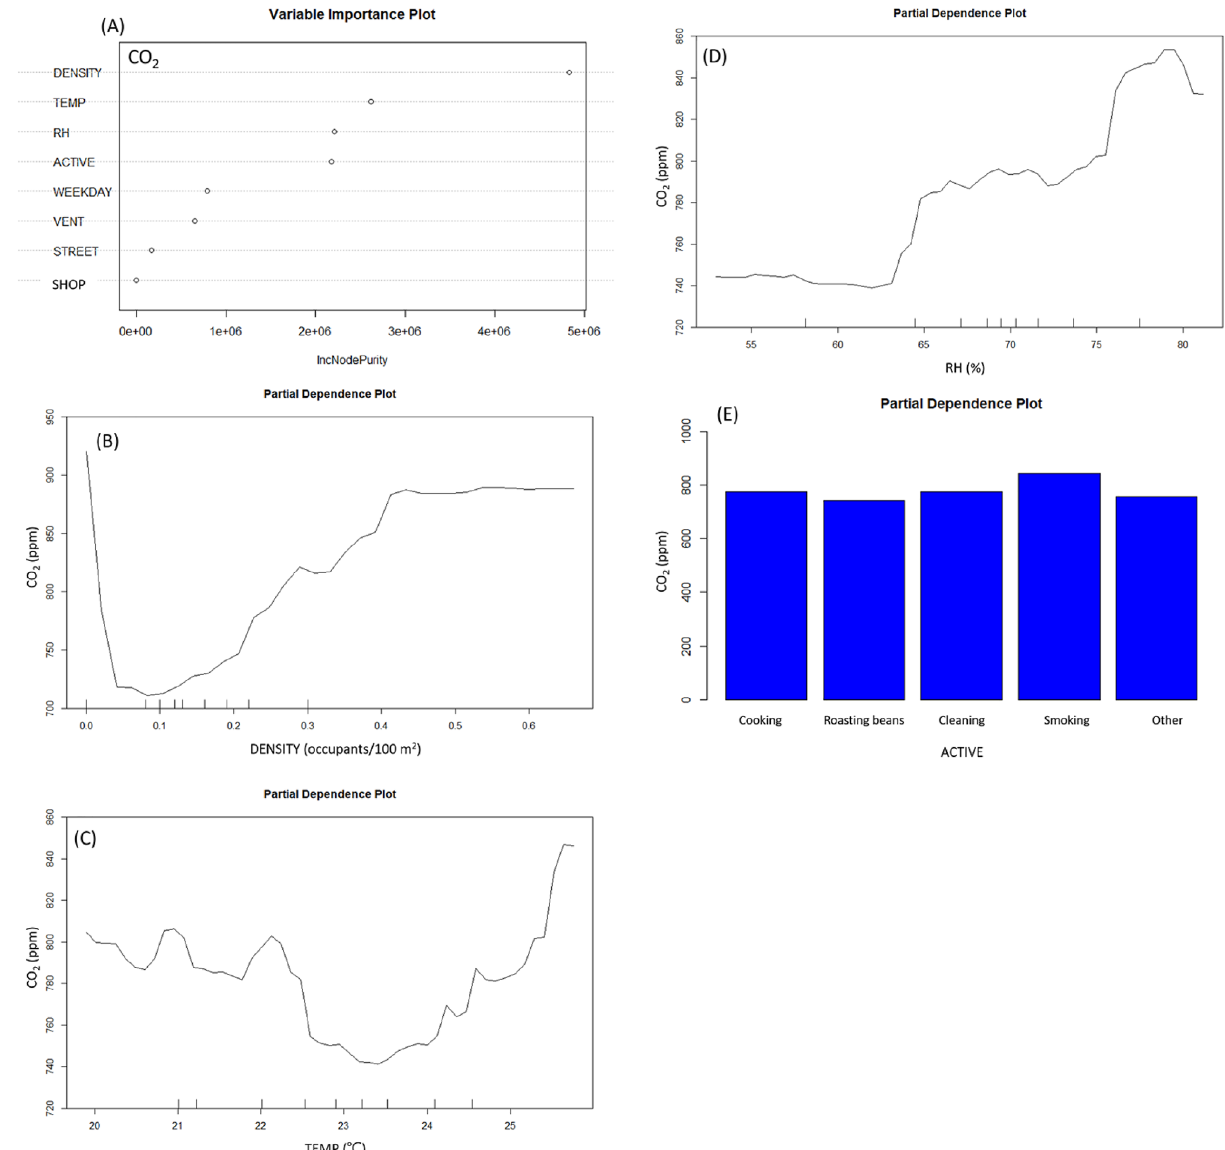
Figure 5. Variable importance rank and partial dependence plot of carbon dioxide (CO 2 ) from Random Forests models. (ACTIVE, Indoor activities; CO 2 , carbon dioxide(ppm); DENSITY, Occupant density (person/m 2 ); RH, relative humidity (%); SHOP, coffee shop A, B, C, D; STREET, locating on the main traffic street; TEMP, temperature(°C); VENT, ventilation